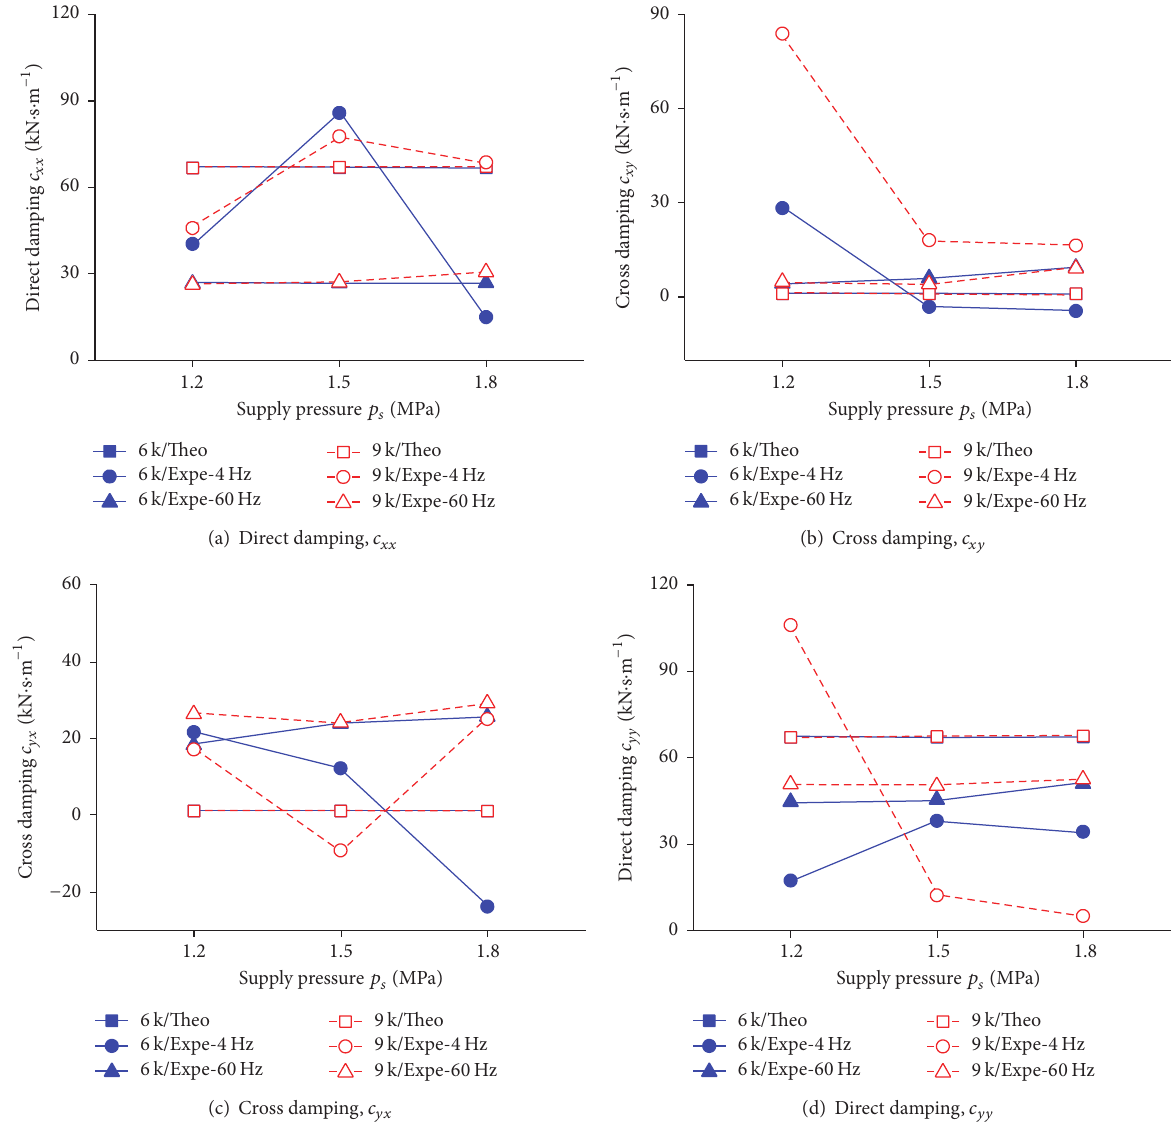
Figure 5: Comparative results of the damping coefficients by noncontact harmonic excitation: two rotating speeds (6,000 r/min and 9,000 r/min), three supply pressures (1.2MPa, 1.5 MPa, and 1.8MPa), and two exciting frequencies (4Hz and 60